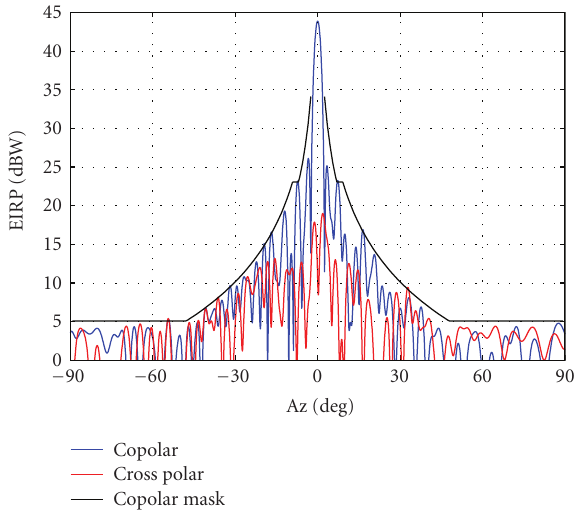
Figure 19: Typical Azimuth Tx Antenna Pattern at 14.25 GHz, 30 o elevation pointing over the horizon.